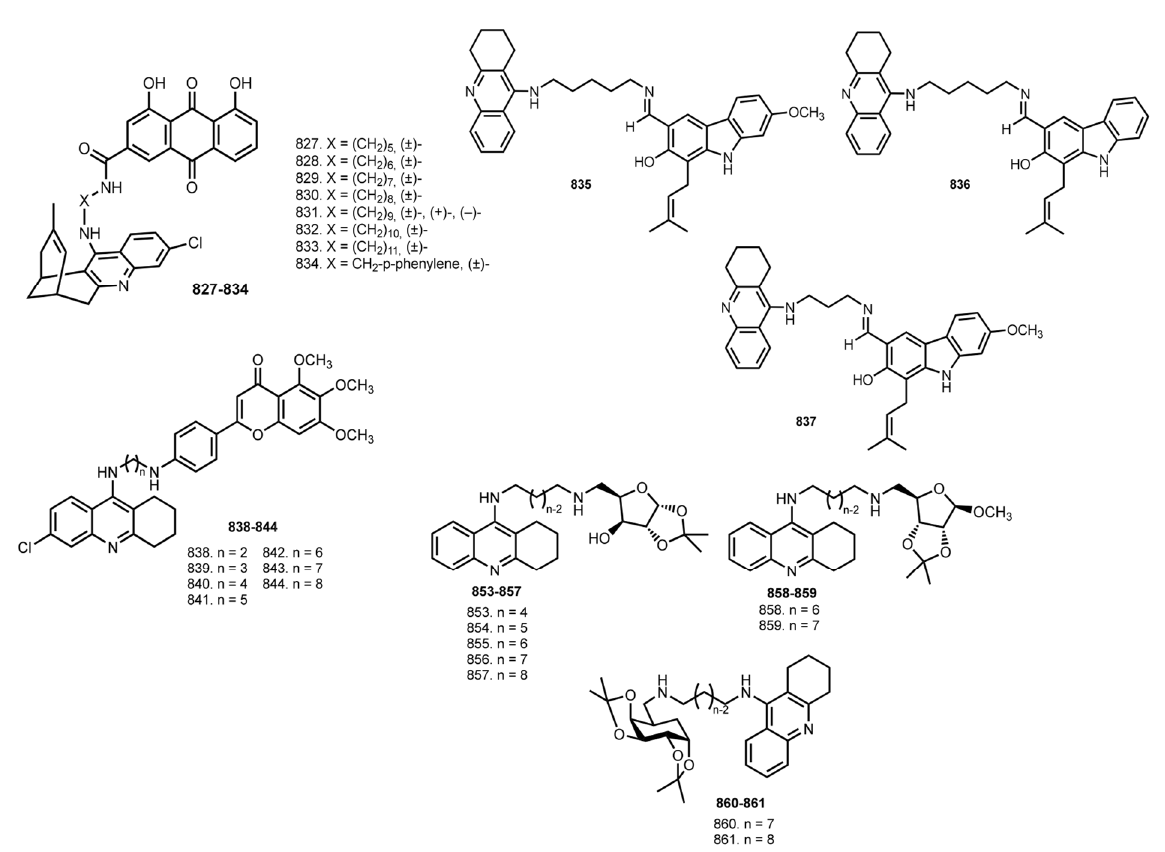
Figure 33. Huprine Y ‐ rhein hybrids 827 ‐ 834 [116], THA ‐ carbazoles hybrids 835 – 837 [117], 6 ‐ Cl ‐ THA–Scutellarin hybrids 838 – 844 [118], THA–resveratrol hybrids 845 – 852 [119], THA hybrids with natural ‐ based D ‐ xylose, D ‐ ribose, and D ‐ galactose 853 – 861 [120].